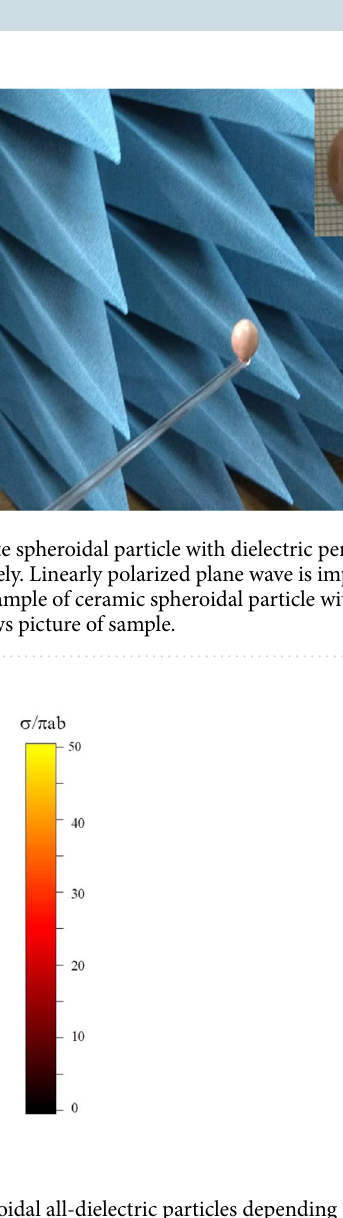
Figure 2. Normalized scattering cross-section of spheroidal all-dielectric particles depending on their aspect ratio a/b and size parameter q = 2 π a / (cid:31) . Experimental cross-section obtained for a/b =1.56 demonstrates three peaks, two of them are related to transverse and longitudinal